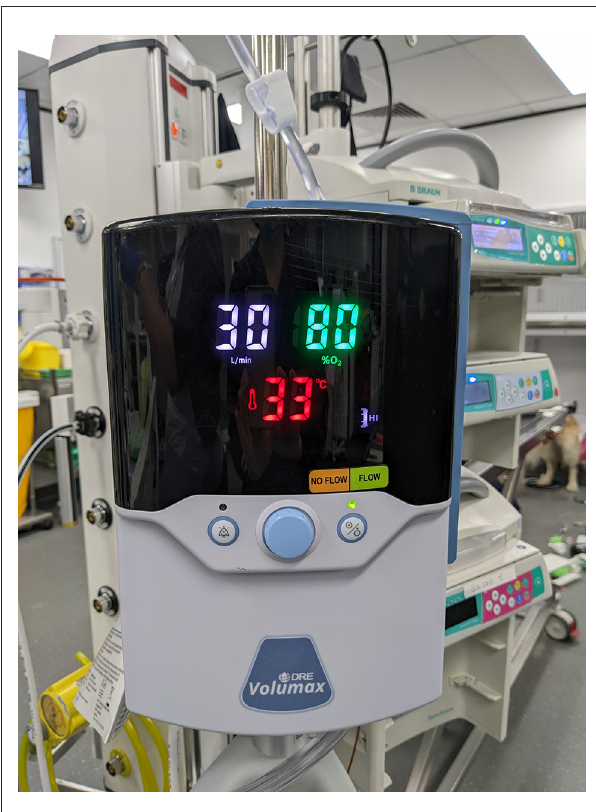
FIGURE2 HFNOT device on which flow rate, FiO 2 , and temperature can be